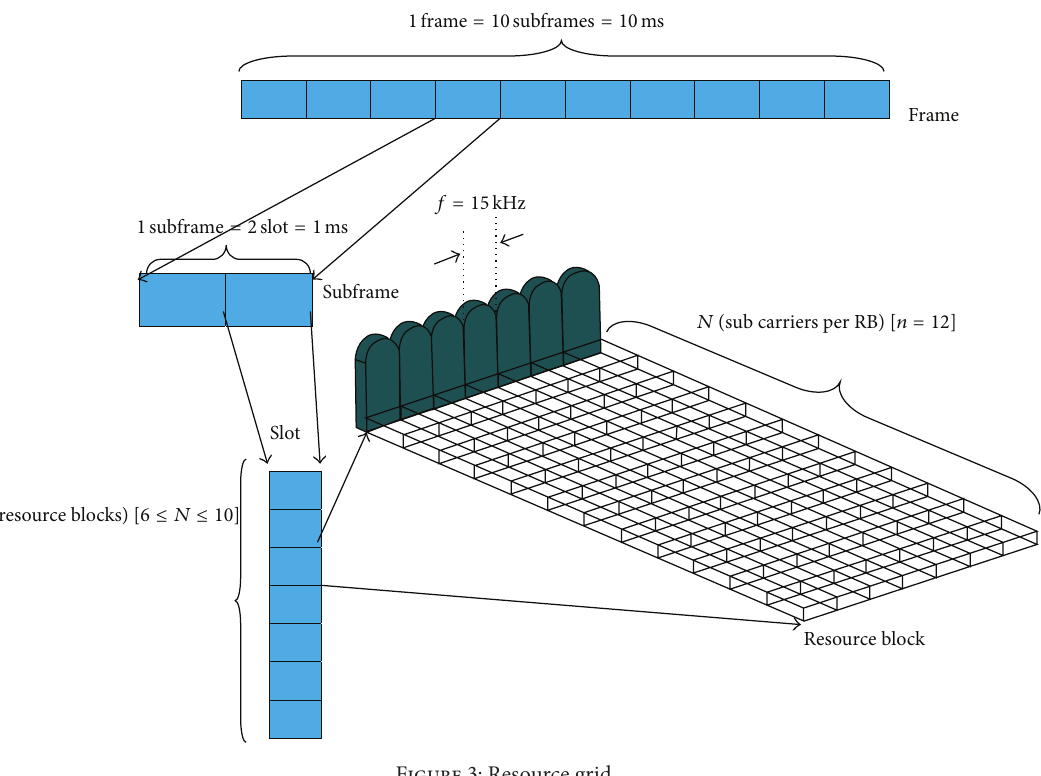
Figure 3: Resource grid.